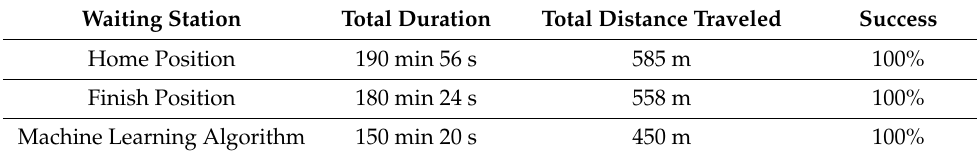
Table 1. Experimental result of three different waiting station usage scenarios.